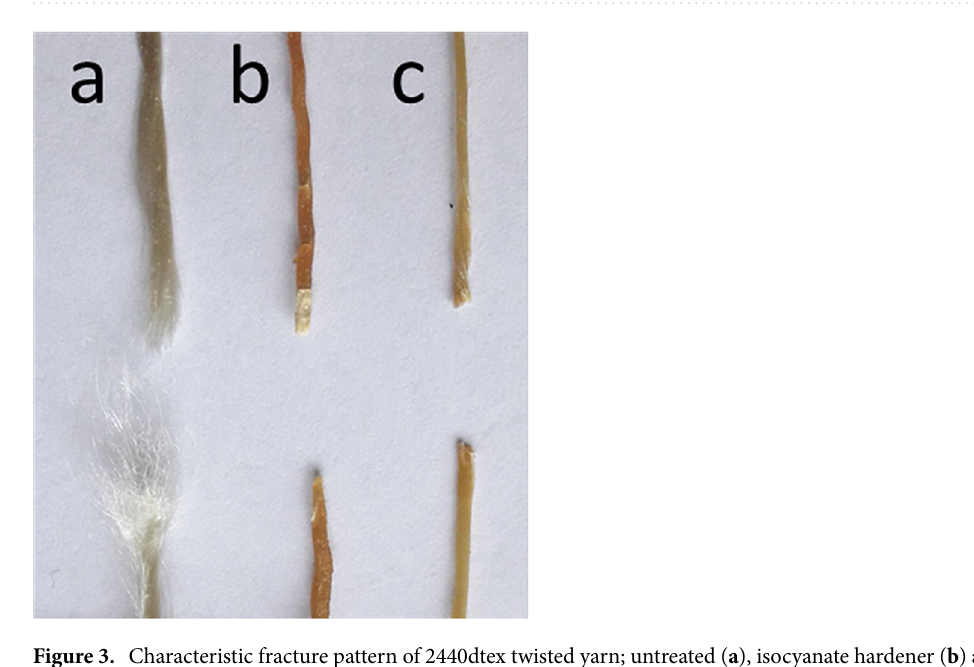
Figure 2. Tensile tests on 2440 dtex yarns; representative load-strain curves and maximum tensile load for untwisted ( a , c ) and twisted ( b , d ) samples, respectively. Immersion time is given in parenthesis ( d ).